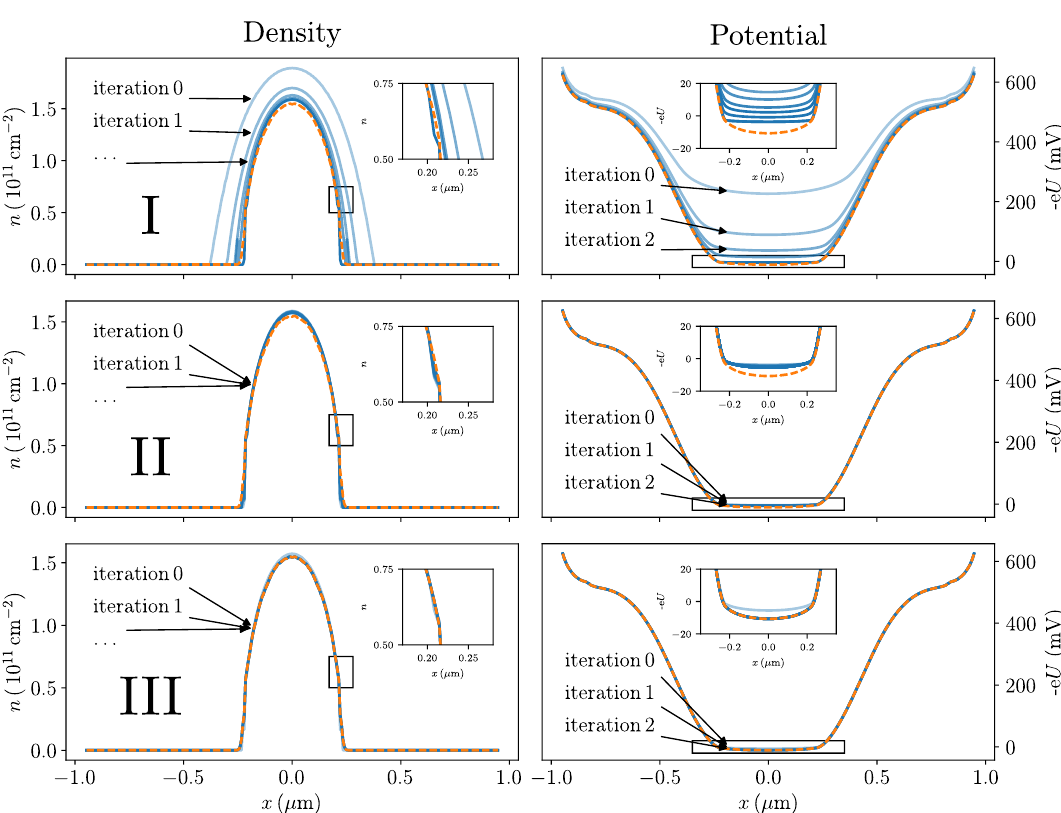
Figure 6: Relaxation of PAA and QAA for the geometry of Fig. 1(b). Left panels: density versus position. Right panels: electric potential versus position. Top panels: iterating over step I (excluding the sites with zero density). Middle panel: iterating over step II (relaxing the Poisson adiabatic approximation). Bottom panels: iterat- ing over step III (relaxing the quantum adiabatic approximation) with several steps II (not shown) performed after each step III . Blue lines: various iterations. Thick orange dashed line: final converged result (FSC). Insets: zooms of the main